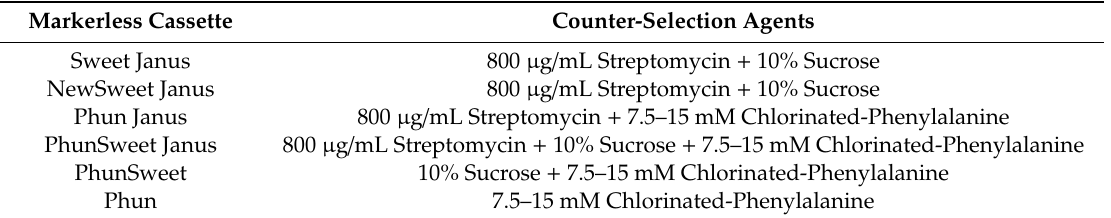
Table 5. Selective agents used in TSA (tryptic soy agar) plates when replacing the markerless cassette in step two